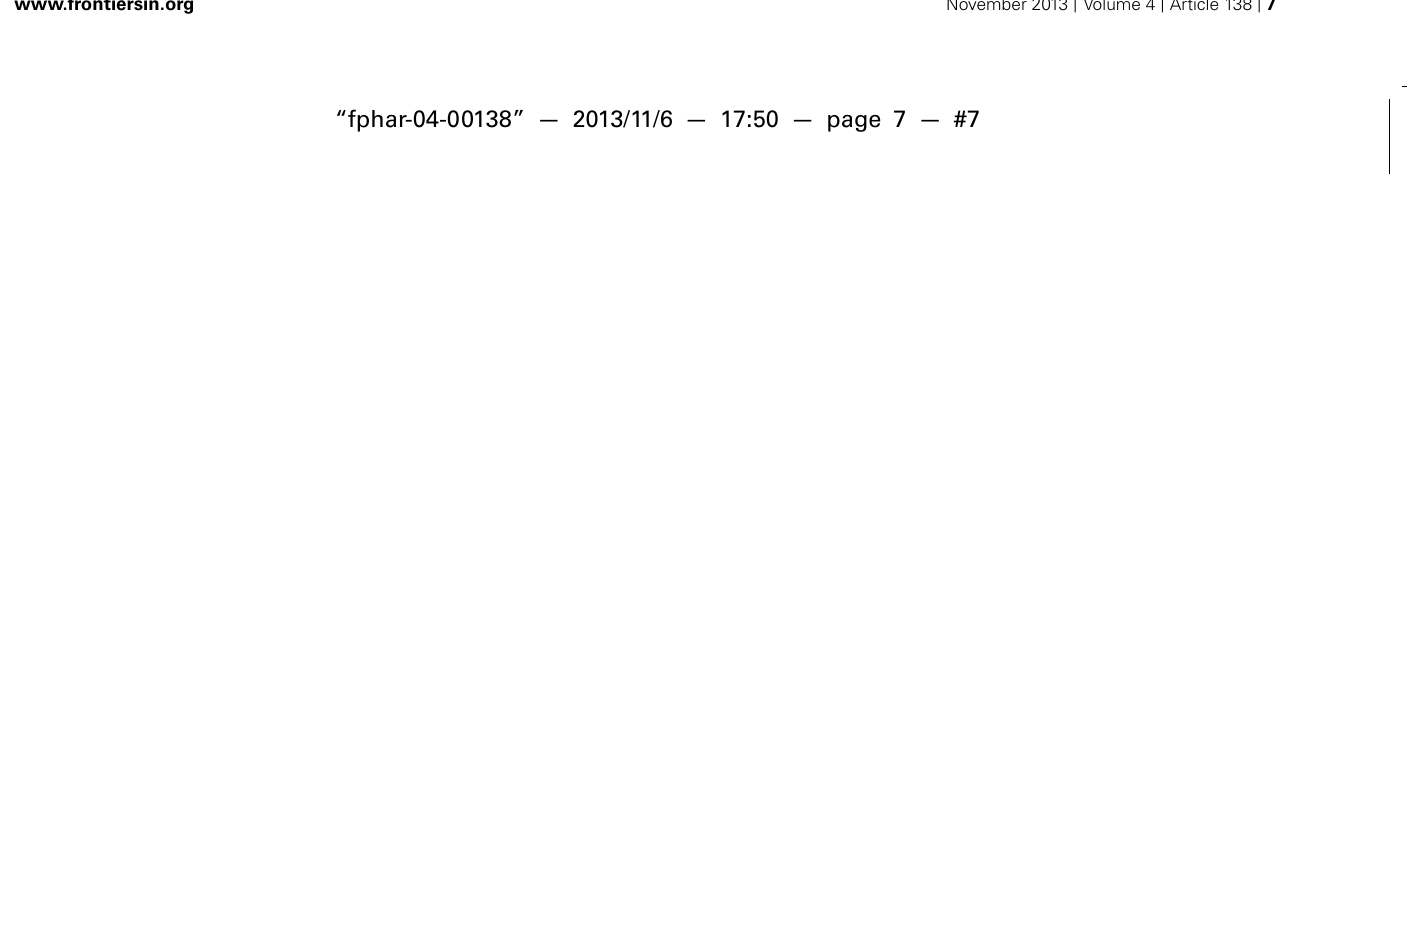
FIGURE 5 | Effects of GSH and DNP-SG on the ATP hydrolytic activity of ABCG2. Sodium orthovanadate-dependent ATP cleavage by wtABCG2 in 2 mM cholesterol-loaded Sf9 membrane vesicles was determined in the presence of increasing concentrations of GSH (A) both in the absence (“basal”) and in the presence of a known